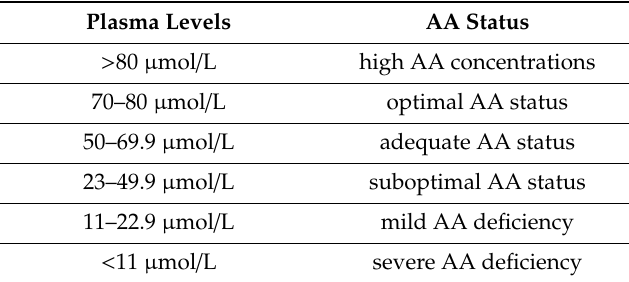
Table 2. AA (ascorbic acid)